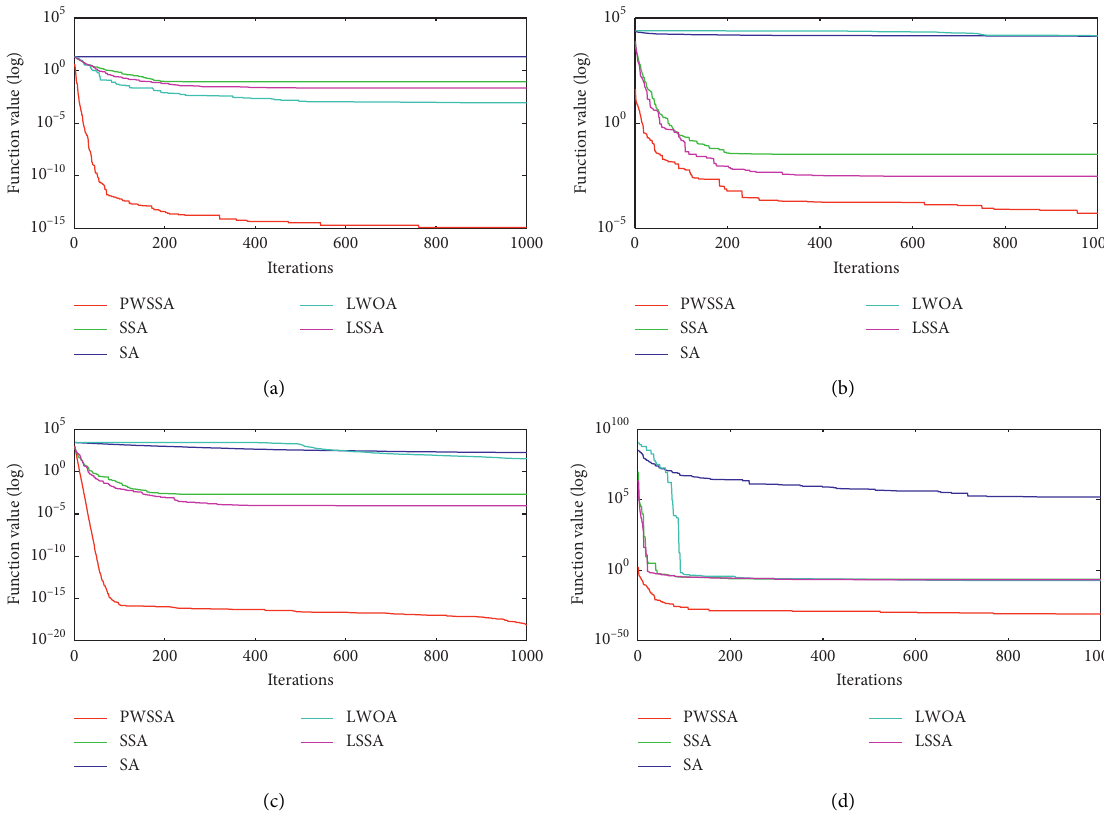
9( D � 100) . (b) f 10( D � 100) . (c) f 11( D � 100) . (d) f 12( D � 100) .